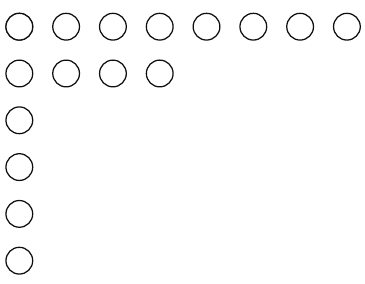
Figure 4: Ferrers diagram for the conjugate partition (6 2 2 2 1 1 1